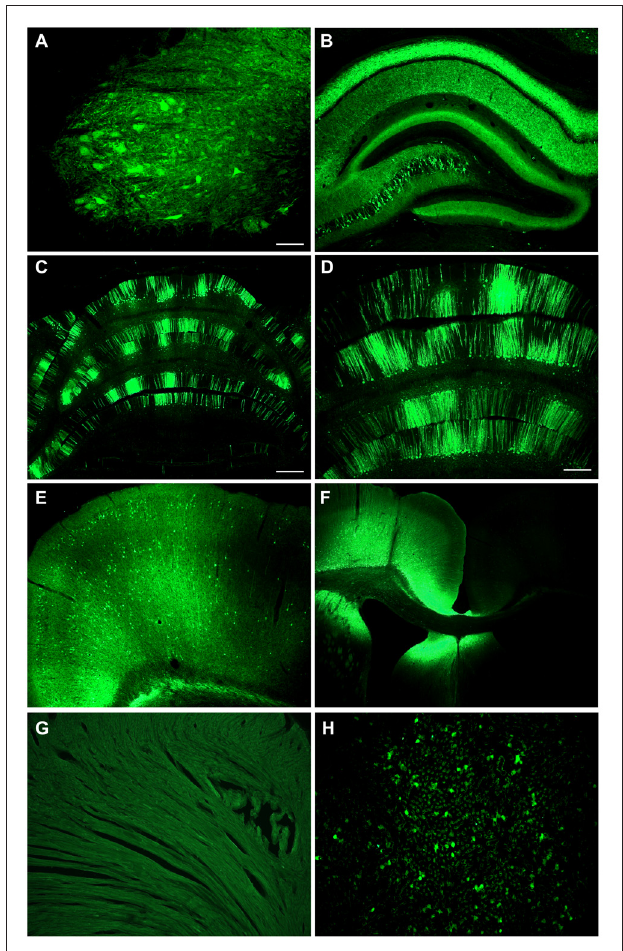
FIGURE 7 | Intracerebroventricular administration produces far reaching expression in the CNS with low level expression in liver. An adult rat was injected with CBA promoter AAV9 into the lateral ventricle. There was a widespread expression throughout the CNS including the spinal cord in the lumbar region (A) , the hippocampus (B) , the cerebellum (C,D) , and the cerebral cortex on the contralateral side (E). (F) There was extremely strong expression along the needle track into the ventricle. (G) No expression was seen in the heart. (H) There was some expression in the liver. GFP immunostaining in (A–H) . Bar in (A) = 134 µ m, same magnification in (B,H) . Bar in (C) = 536 µ m, same magnification in (F) . Bar in (D) = 268 µ m, same magnification in (E,G)